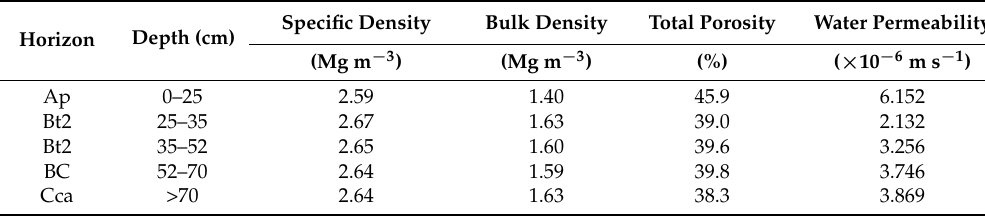
Table 4. Selected physical properties of the studied